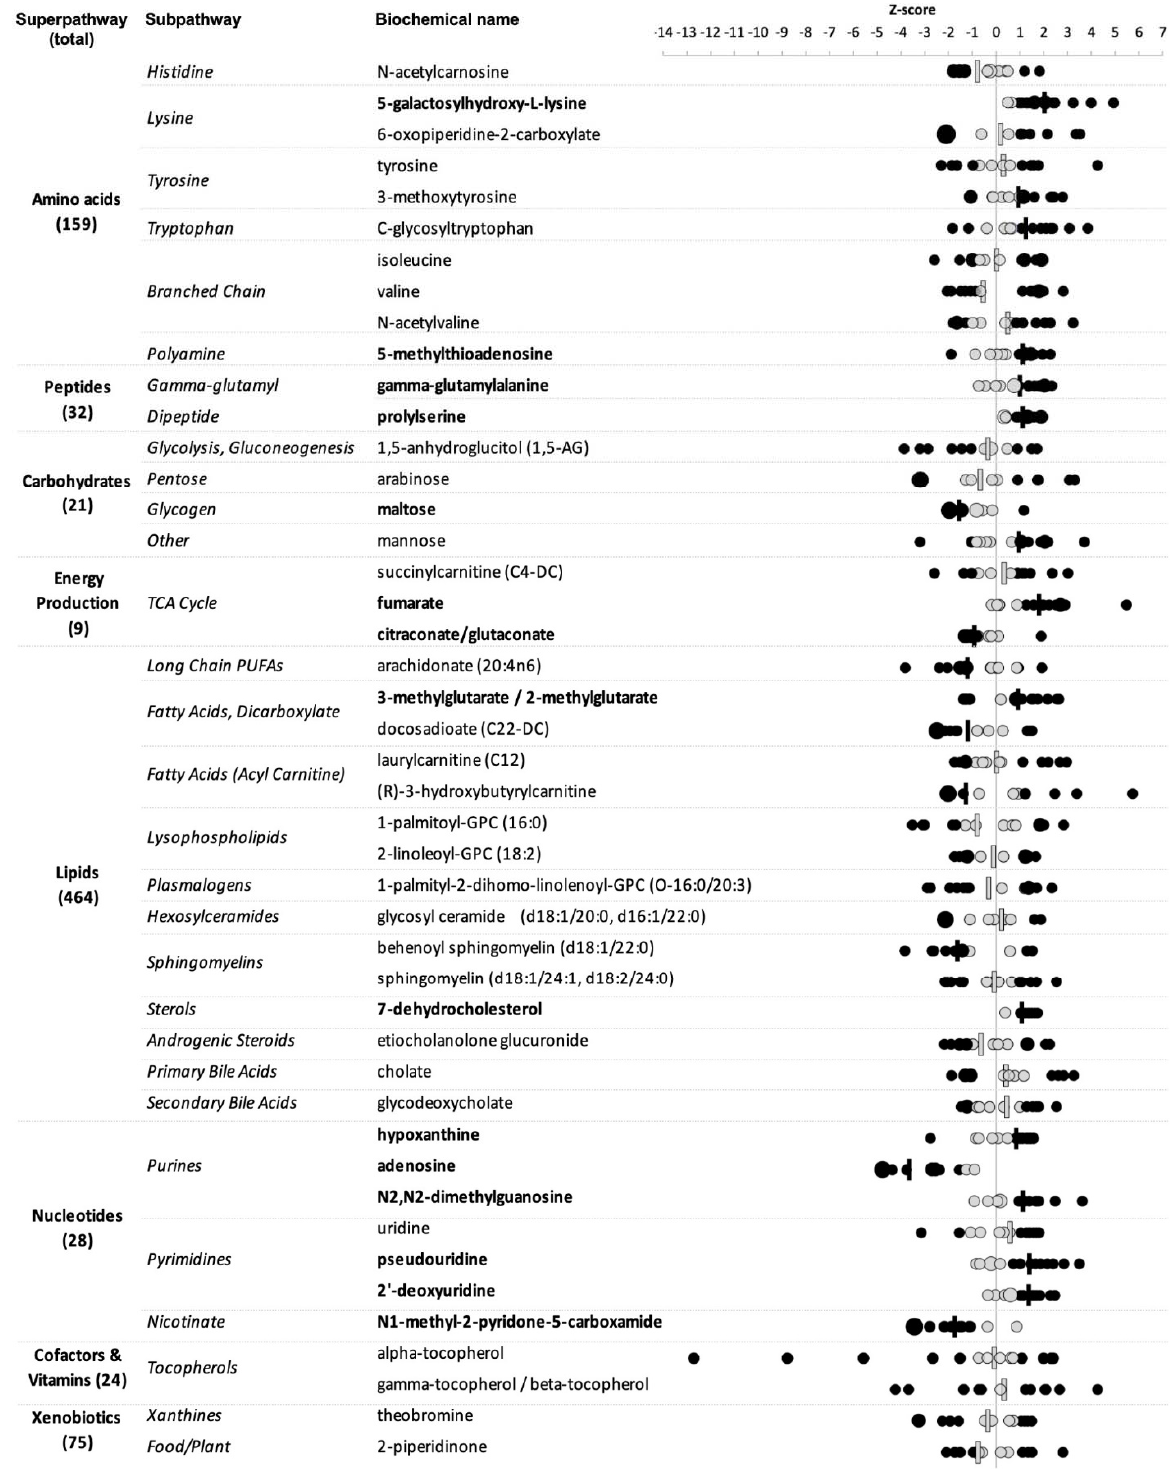
Figure 2. Specific biochemicals and their respective pathways identified as potentially altered in GBCA-exposed patients. Circles indicate individual patient Z-scores with larger sizes denoting multiple patients; bars indicate median values; black—values 1 SD above or below the normalized reference cohort mean, gray—values less than 1 SD from the normalized reference cohort mean. Bolded biochemical names indicate those for which alterations were directionally consistent across patients.